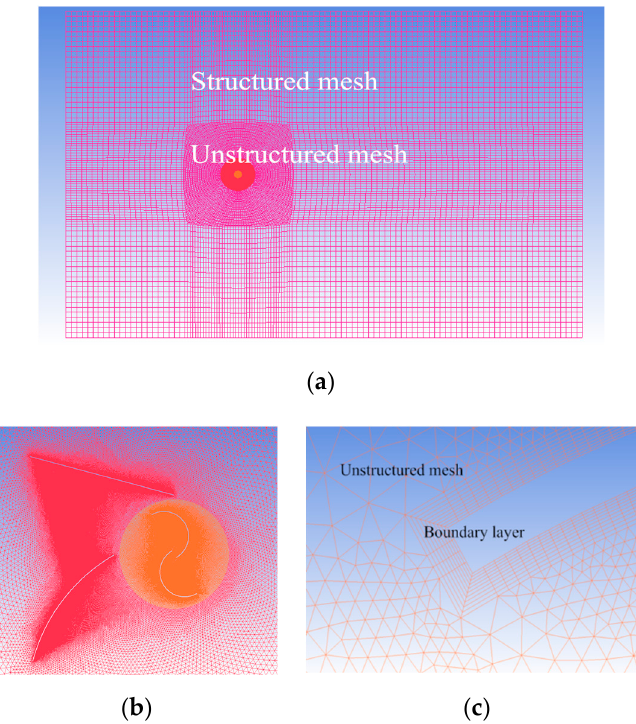
Figure 7. ( a ) Overview of the calculation domain; ( b ) local image near the interface; ( c ) boundary layer mesh of the rotor.